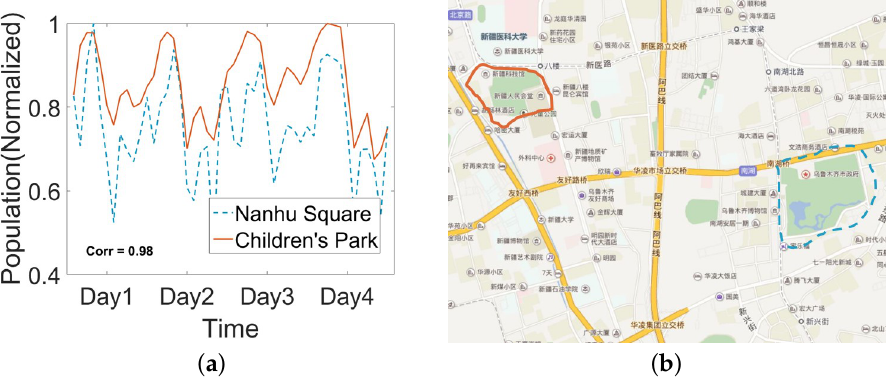
Figure 13. ( a ) Population flow trend for two particular regions. The time slot is 2 h. ( b ) The locations of two particular regions. MATLAB 2015b is used to draw the borderline on the Baidu Map web page.